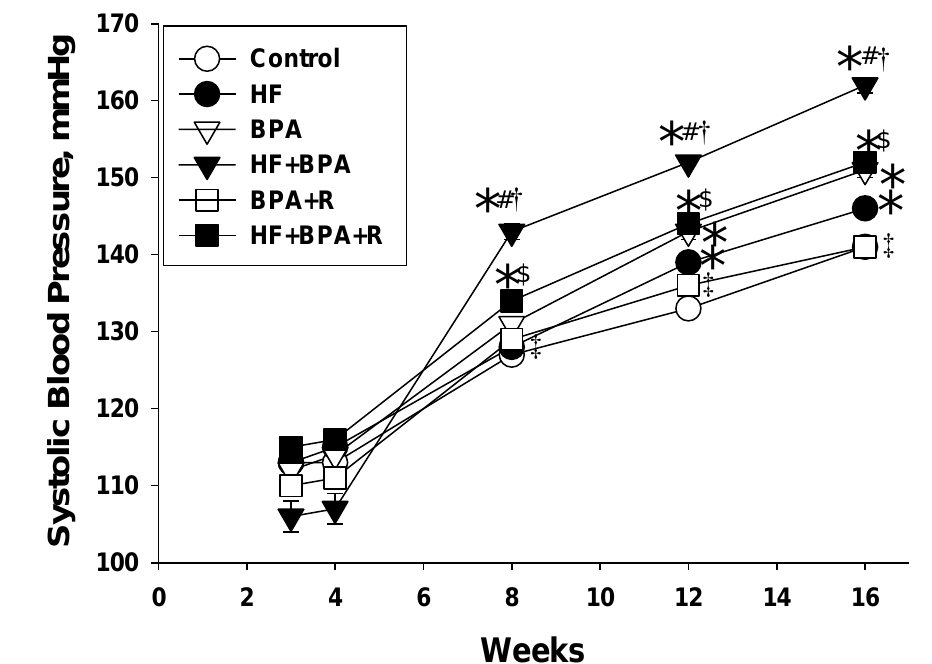
Figure 1. Effects of maternal high-fat diet (HF), bisphenol A (BPA), and resveratrol (R) on systolic blood pressure (SBP) measured in male offspring at 3, 4, 8, 12 and 16 weeks of age. n = 7 – 8/group; * p < 0.05 versus control; # p < 0.05 versus HF; † p < 0.05 versus BPA; ‡ p < 0.05 versus HF + BPA; $ p < 0.05 versus BPA + R.